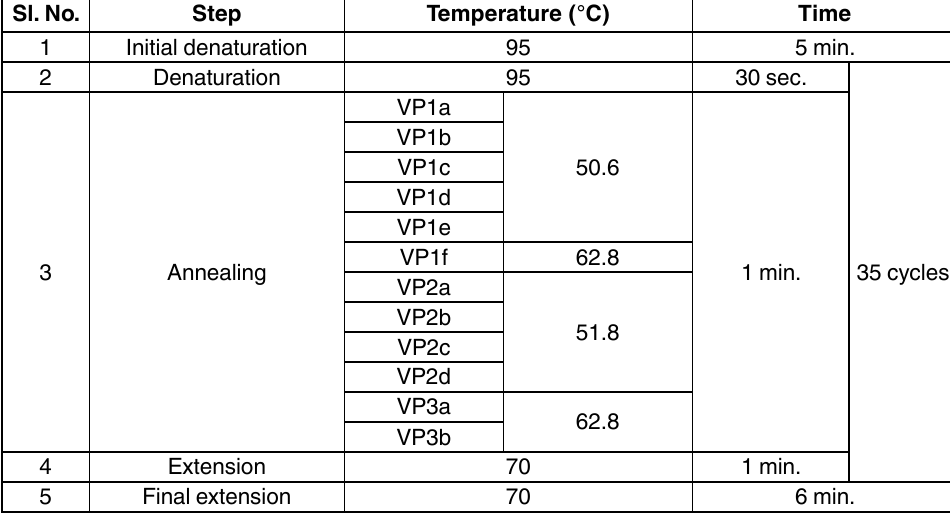
table 3. The PCR conditions optimised for the amplification of VP1, VP2 and VP3 genes sl. No.